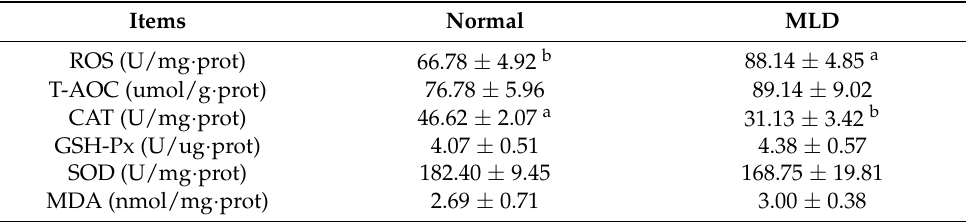
Table 6. Effects of MLD on hepatic antioxidant responses of largemouth bass (means ±